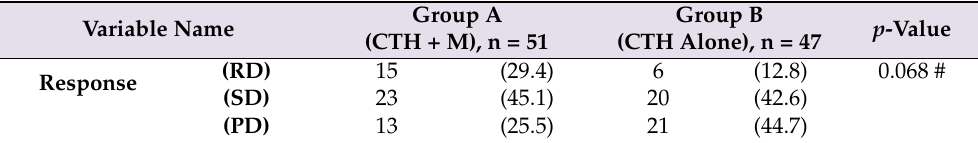
Table 3. Response of the studied participants after 6 months of treatment (n = 98).